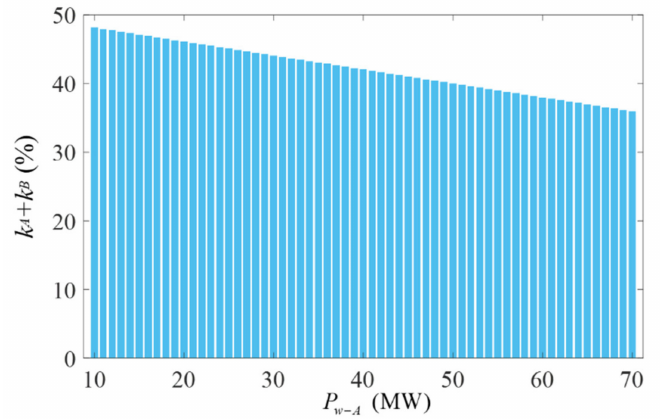
Figure 10. The relationship between P w − A and k A + k B